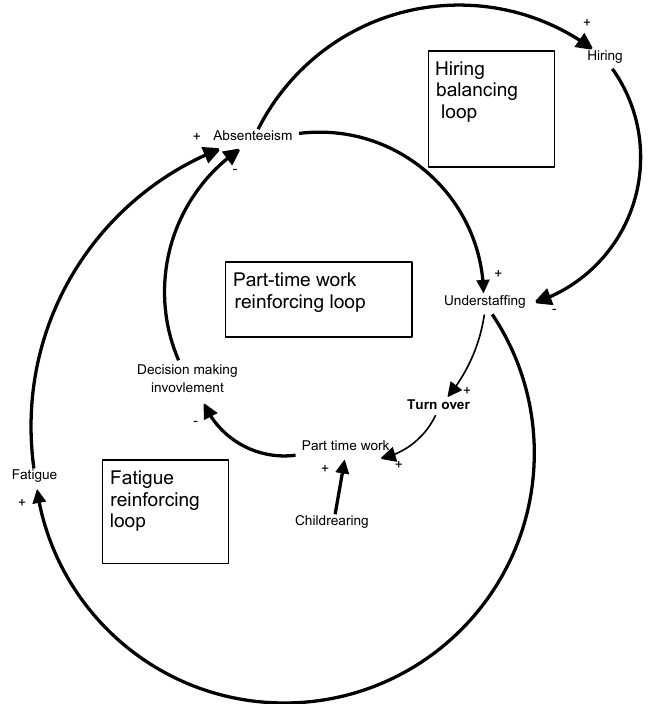
Figure 4. CLD of the model showing part-time work and fatigue reinforcing loops and the hiring balancing loop.